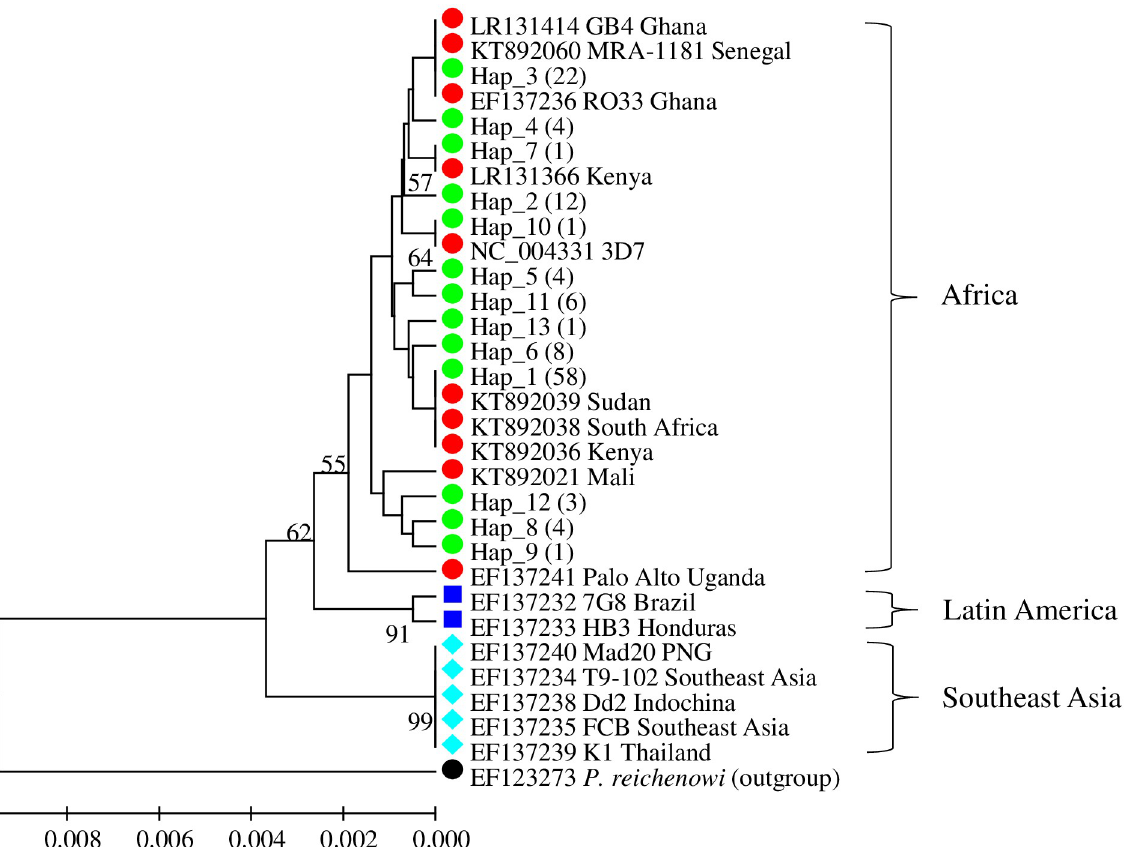
Fig 3. Phylogenetic inference using UPGMA method. The percentage of replicate trees ( > 50) in which the associated pfs47 haplotypes clustered together in the bootstrap test (1000 replicates) are shown next to the branches. The evolutionary distances were computed using the Kimura 2-parameter method and are in the units of the number of base substitutions per site. The tree was rooted to a reference sequence from P . reichenowi and the scale axis presented under the tree. Green dots represent the haplotypes identified in this study in Western Kenya, values in parentheses indicate the number of sequences, red dots represent haplotypes previously identified from other studies in African countries, blue filled squares represent haplotypes from Latin America, the aqua diamond represents haplotypes from Southeast Asia, and the black dot represents the outgroup. Eighteen sequences were retrieved from GenBank: (NC_004331, EF137232, EF137233, EF137234,